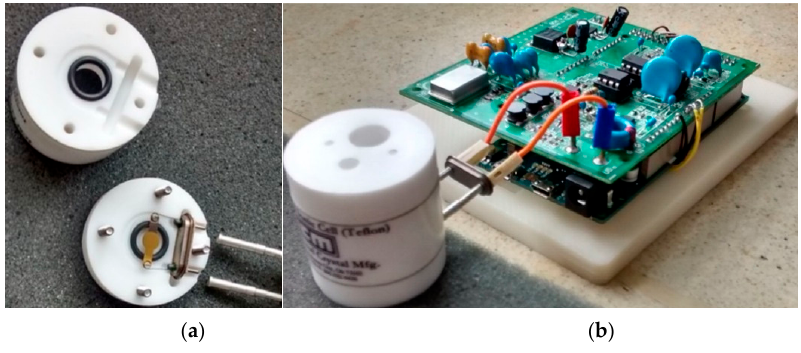
Figure 5. Gamry Cell ( a ) and Prototype System ( b ).